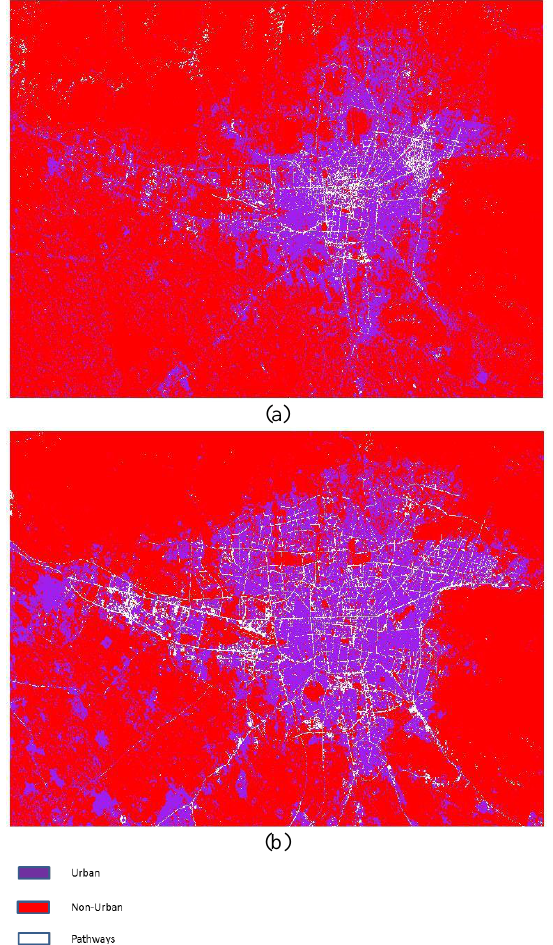
Figure 2. Two classified images used in the study, image obtained in 1998 (a) and in 2010 (b)